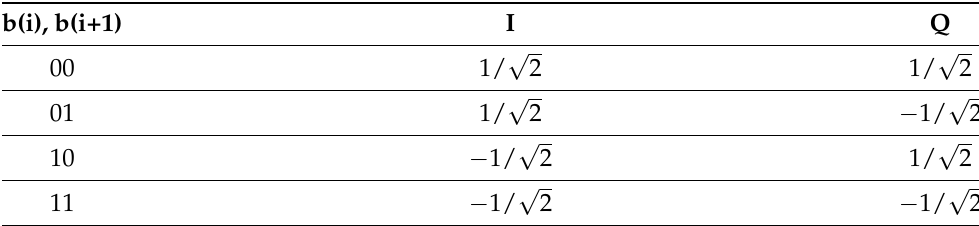
Table 6. QPSK modulation [2].